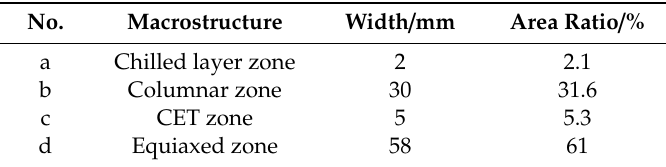
Table 3. Width of each zone of slab macrostructure (mm).